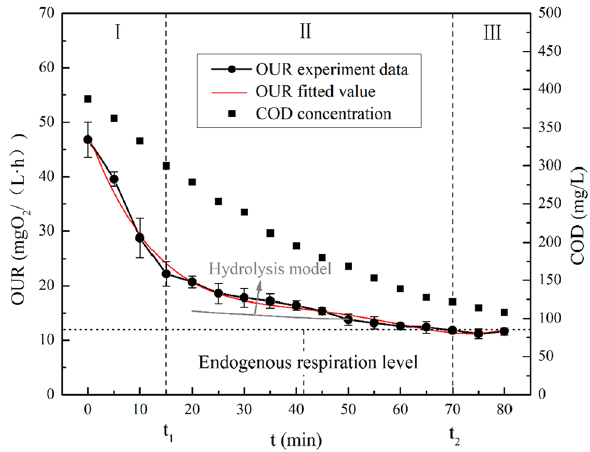
Figure 3. Complete OUR curve of wastewater COD